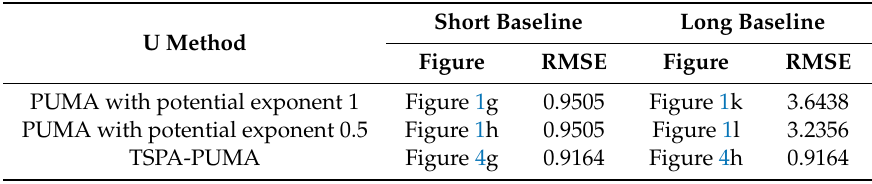
Table 2. Statistical information of PU performance in Figure 1g,h,k,l, and Figure